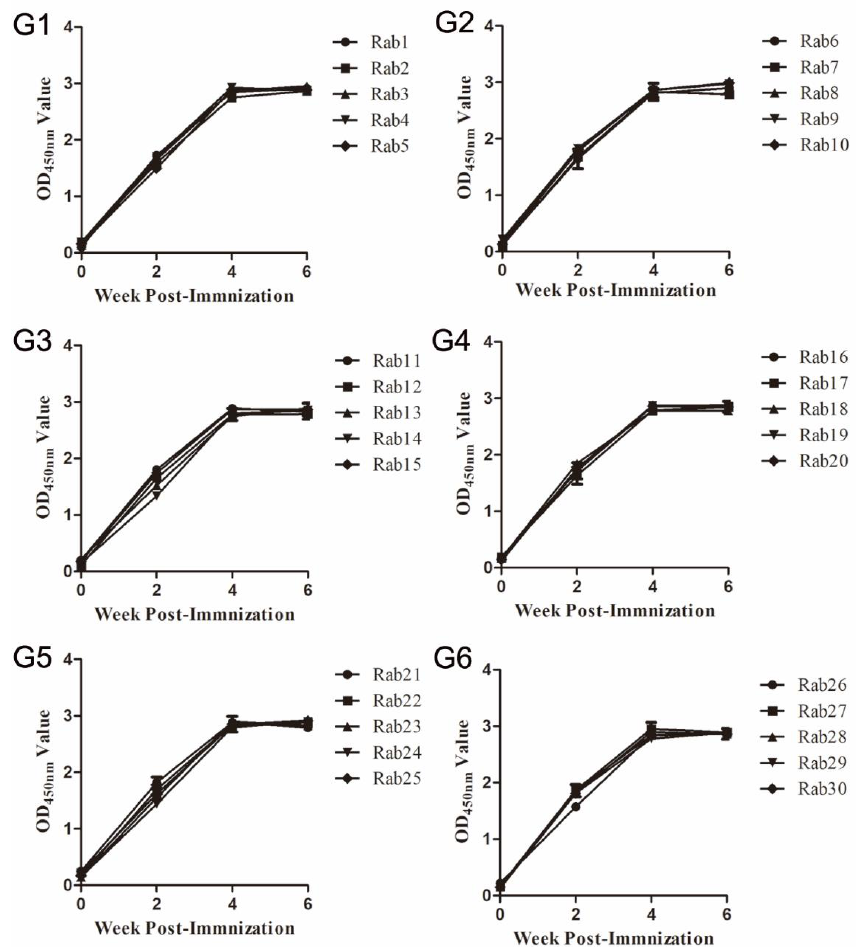
Figure 2. Seroconversion in rabbits immunized with Pep VKLYTS ( G1 ), Pep PSRPF ( G2 ), Pep EPTV ( G3 ), Pep EPTVKLYTS ( G4 ), Pep EPTVKLYTSPSRPF ( G5 ), or sp239 ( G6 ). Serum samples were